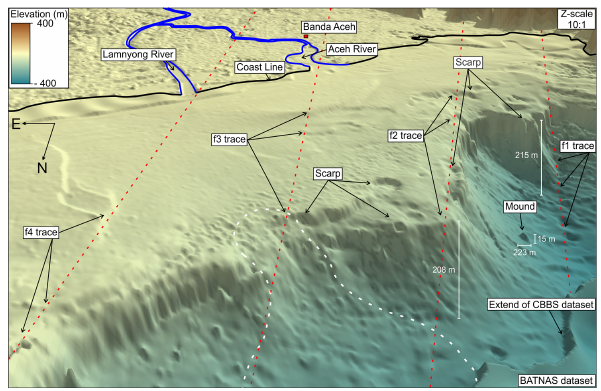
Figure 5. 3D topographic view of the northeastern shore and waters of Banda Aceh. The slope heights along f1 and f2 as well as the mound height and length are indicated. Colors enhance significant features along the continental